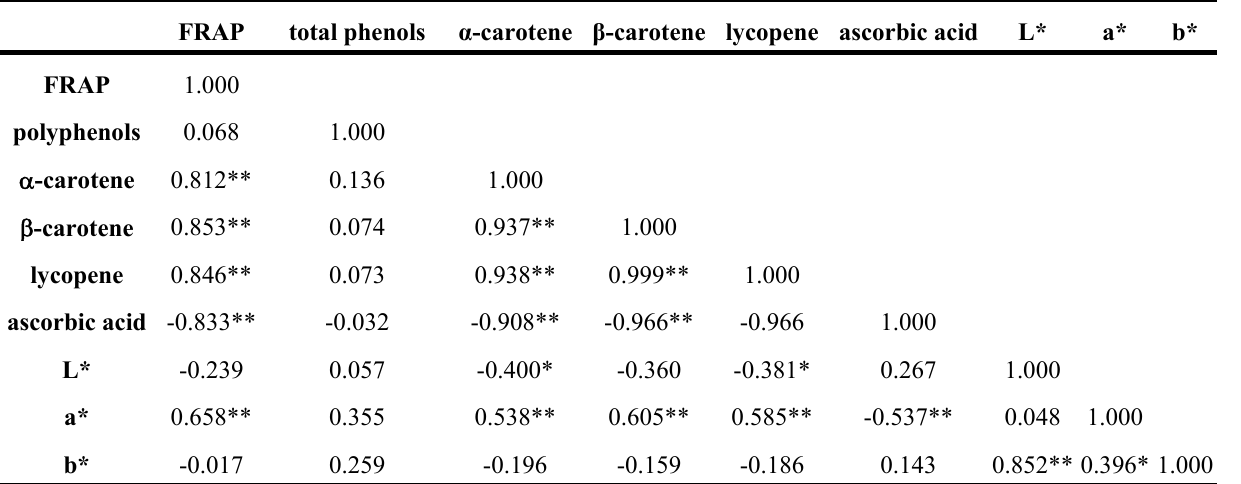
Table 6. Pearson’s linear correlation coefficients among Solanum indicum L. berries data. a FRAP total